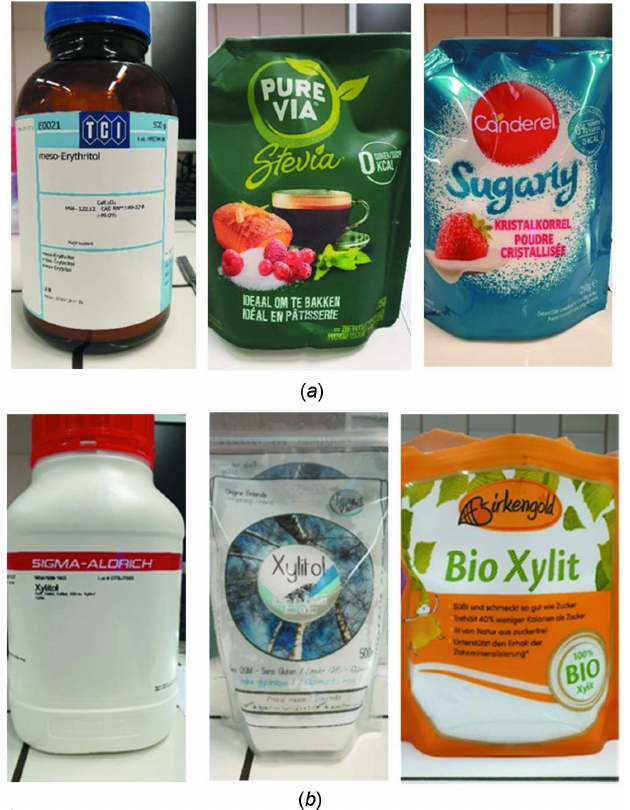
Figure 2 Commercial sources of ( a ) erythritol and ( b ) xylitol used.